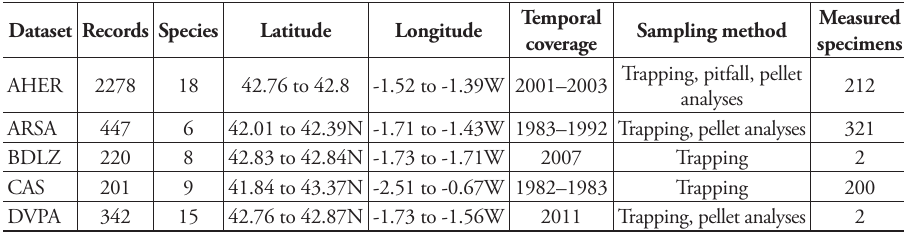
Table 1. Overview of the datasets. Dataset Records